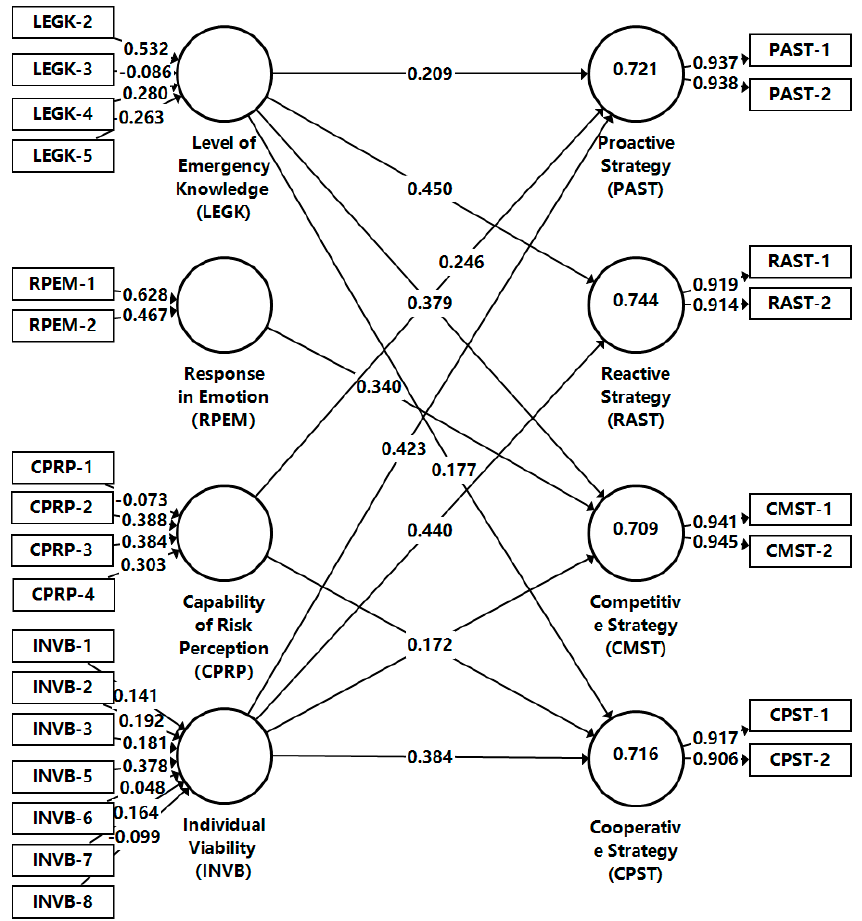
Figure 3. Final PLS structural equation model.